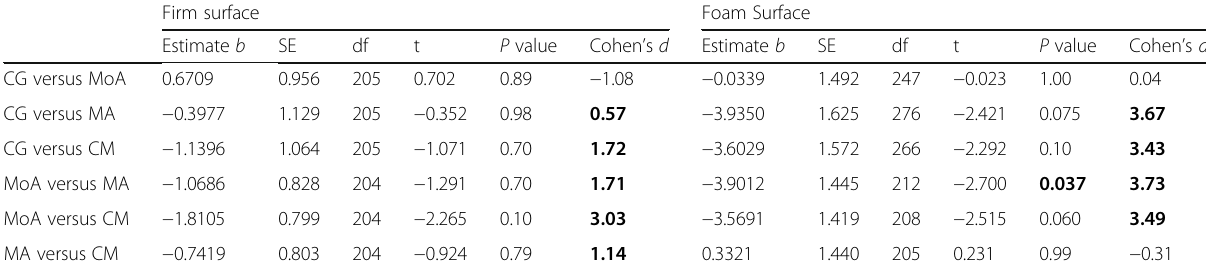
Table 3 Results of post-hoc Tukey ’ s range tests for the diagnosis-by-surface interaction Firm surface Foam Surface